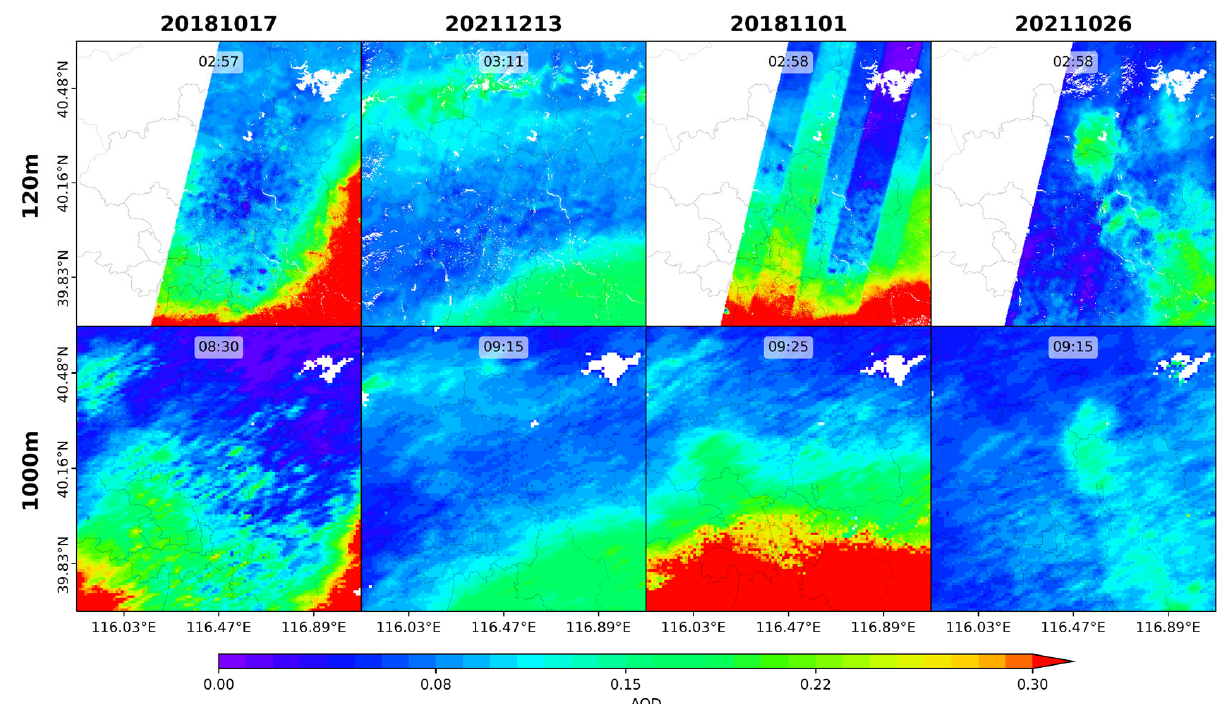
Figure 4. High-value AOD spatial distributions of the proposed algorithm (the first row) and MODIS MAIAC (the second row) in four retrieval days (UTC).